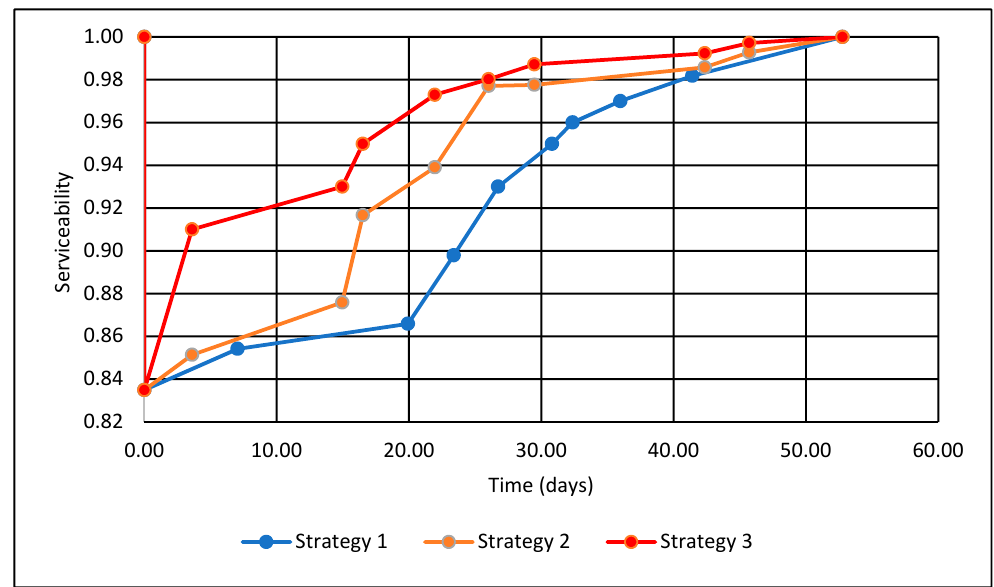
Figure 14. Comparison of three resilience restoring strategies based on serviceability.